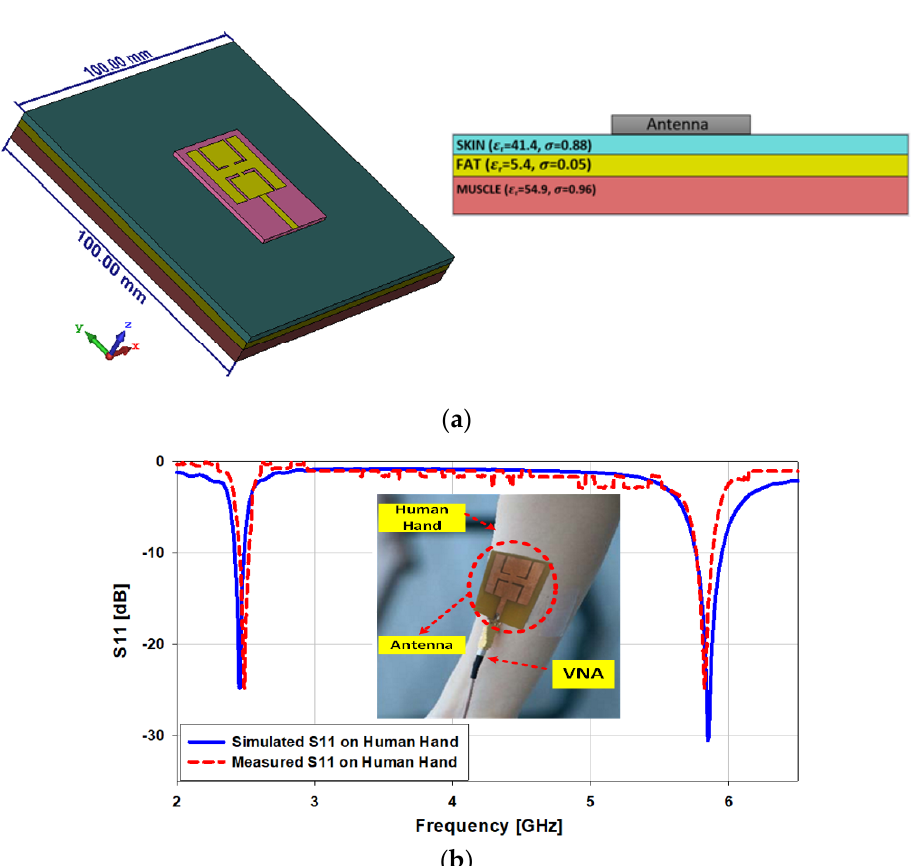
Figure 12. ( a ) Human body tissues; ( b ) comparison between the simulated and measured S 11 on the human hand.